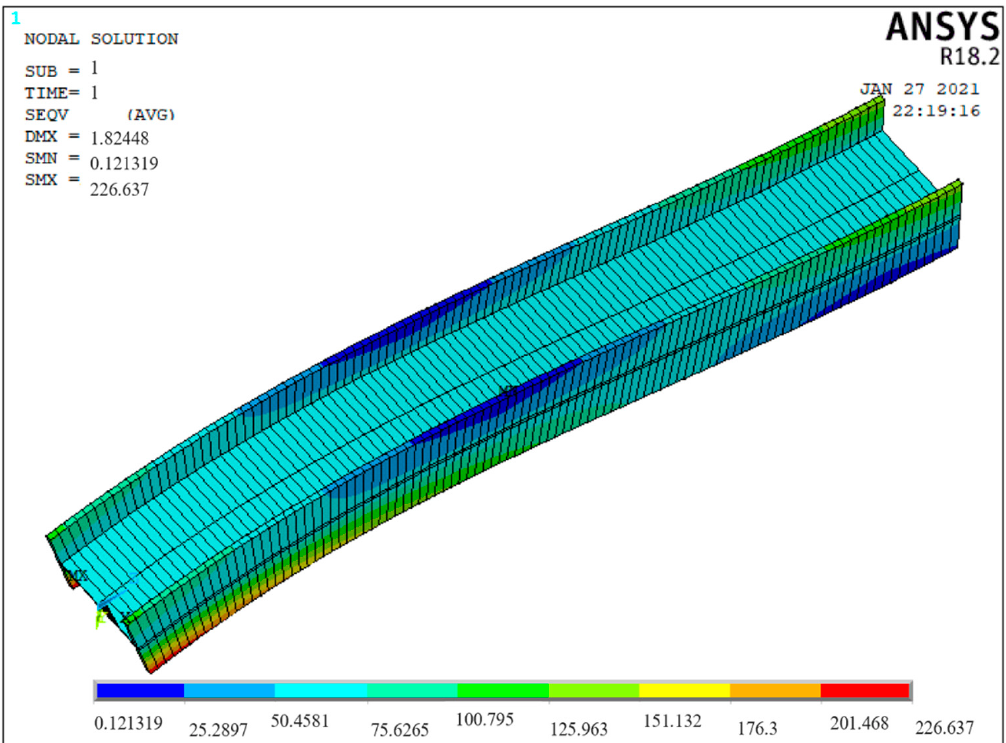
Figure 13. Von Mises stress diagram of derrick legs.